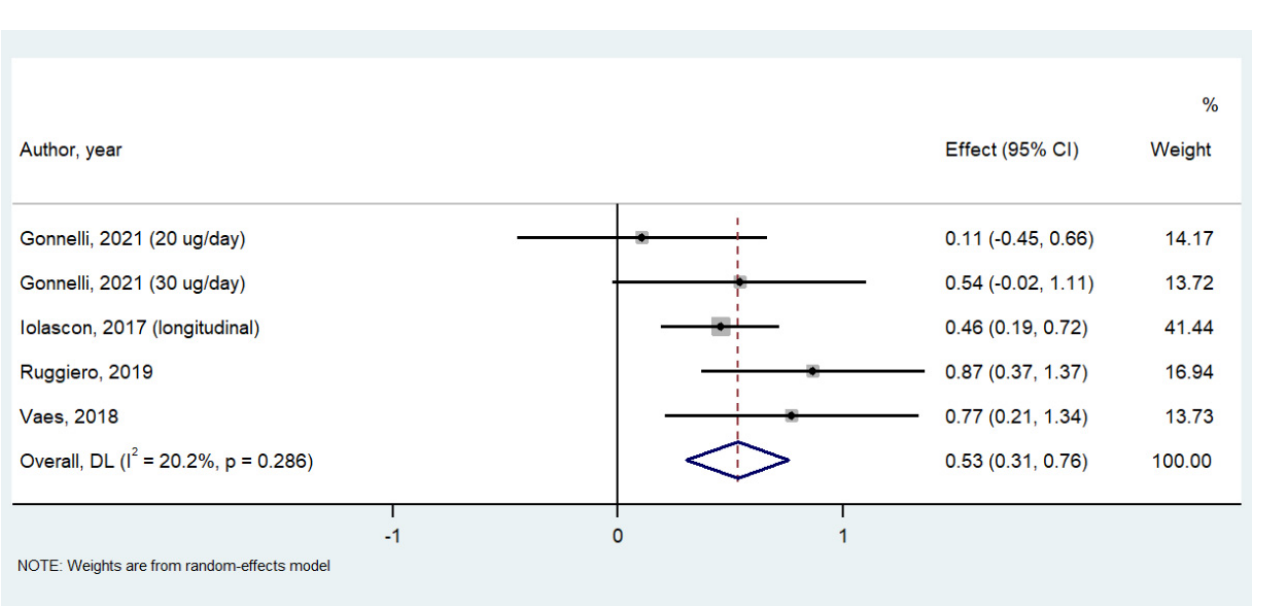
Figure 3. Forrest plot of the effect of calcifediol on leg extension. References [15,17,18,22]. 3.4. Meta-Regression Analysis Since no outcome having at least four studies—the minimum number of studies for running a meta-regression analysis—had a high heterogeneity (I 2 = 50%), meta-regression analyses were not made. 3.5. Adverse Events Adverse events were reported in some of the studies included. In the study of Bis- choff-Ferrari et al. [17], in the group treated with calcifediol, no cases of hypercalcemia were observed, even if serum calcium was assessed several times during the follow-up. Similarly, Iolascon et al. [18] did not report any side effects during six months of follow- up. Finally, Vaes et al. [21] reported one or more mild adverse events in 39% of the patients treated with calcifediol; however, no differences were reported compared to placebo. 3.6. Risk of Bias Assessment As shown in Supplementary Table S1, the studies included suffer on some potential biases, including the lack of a priori power assessment in almost all of the studies, the lack of information in comparing the interventions before and after calcifediol administration, and that the outcomes of interest were often taken only at baseline and at follow-up, with- out intermediate evaluations.